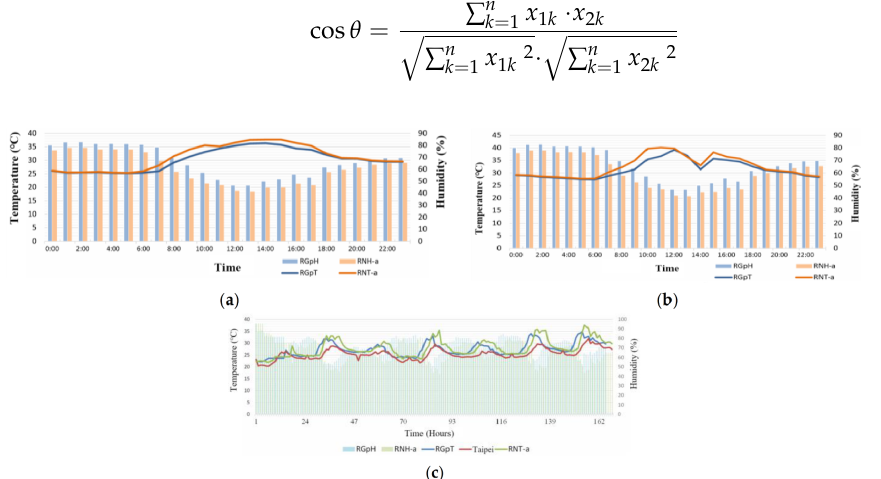
Figure 5. Temperature and humidity when solar panels are used to provide shade for temperature reduction. ( a ) 10 May, ( b ) 11 May, and ( c ) temperature reduction efficiency. Table 8. Region B: Similarities of solar panel shading. Curve Taipei × RGpT Taipei × RNTa RGpT × RNTa Similarity 99.9133% 99.8382%